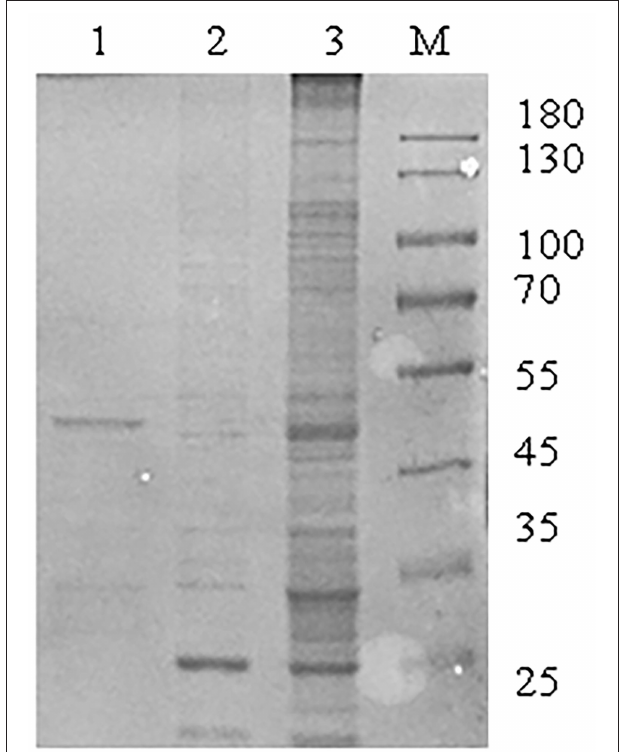
FIGURE 1 | Identification of interaction factors between Swine acute diarrhea syndrome coronavirus (SADS-CoV) M protein and host. A large number of glutathione-S-transferase (GST)-M recombinant proteins were expressed and purified by magnetic beads with GST fusion protein for purification and GST pull-down experiments. Then sodium dodecyl sulfate-polyacrylamide gel electrophoresis (SDS-PAGE) was used for isolation and identification. M: page ruler protein marker; Lane 1: purified GST-M fusion protein elution solution; 2: GST protein pull-down result; 3: GST-M protein pull-down